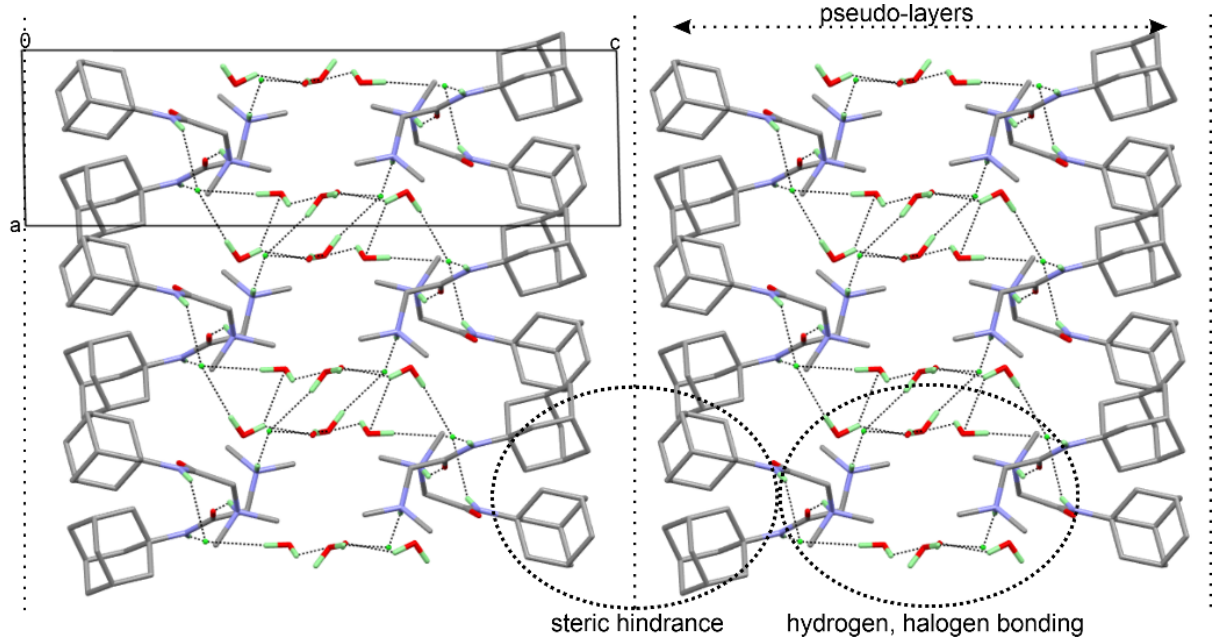
Figure 5. View of the three-dimensional packing of the molecules along b direction of DMG-Am revealing the formation of pseudo-layers; hydrogen and halogen bonding interactions are shown as dotted lines.